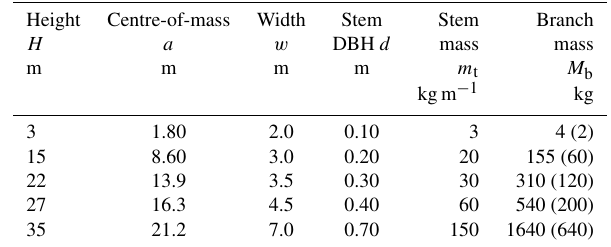
Table 1. Numerical values for the mass distribution of spruce for different tree heights. Table is constructed from data contained in Indermühle (1978), Kalberer (2006) and Kramer (1988). The stated values represent average values for spruce trees in alpine environ- ments. Values are approximate and will change depending on their location in forest, slope exposition, etc. Branch mass includes nee- dle mass, which is given in parenthesis. Intercepted snow mass is not included in the